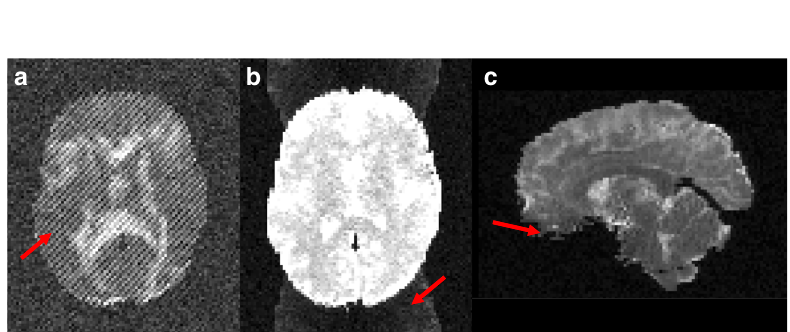
Green cells indicate a signi fi cant positive in fl uence ( p < 0.05) and red cells indicate a signi fi cant negative impact ( p < 0.05). Numbers indicate the estimated mean effect on the metric and its standard deviation.The fi rst column of the table represents the different parts of the processing pipeline that we have grouped into categories. The other columns represent the metrics: VC valid connections, VB valid bundles, IB invalid bundles, OL overlap, OR